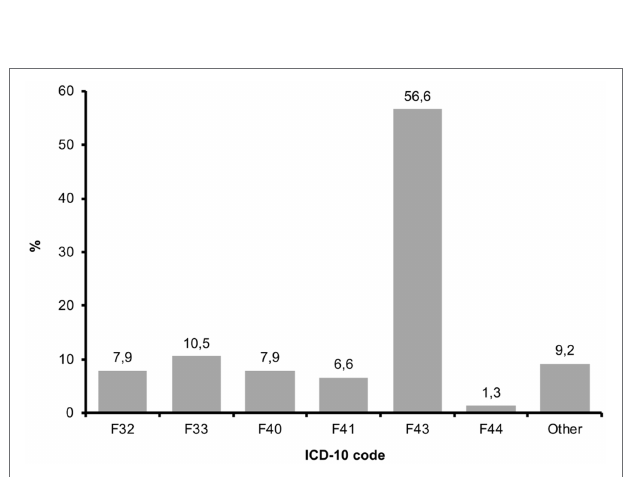
FIGURE 2 | Patients’ main diagnosis grouped after ICD-10 code ( N = 76).